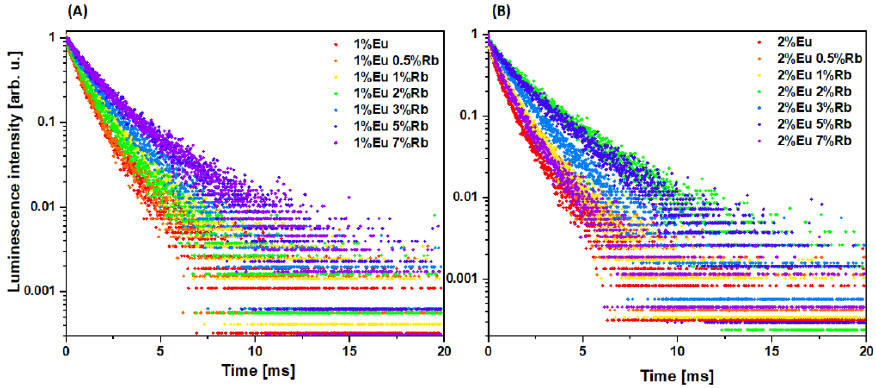
Figure 7. Luminescence decay profiles of ( A ) Ca 10 − (0.1 + x) Eu 0.1 Rb x (PO 4 ) 6 (OH) 2 and ( B ) Ca 10 − (0.2 + x) Eu 0.2 Rb x (PO 4 ) 6 (OH) 2 , where x equals 0.5, 1, 2, 3, 5, 7 mol% of Rb + ions.